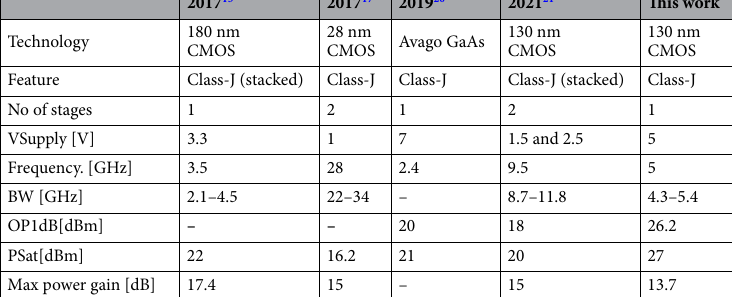
Table 2. Performance comparison of recent Class-J